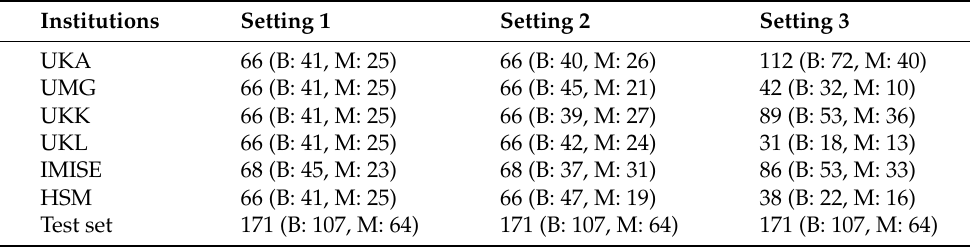
Table 1. Class distributions over the six Germany-wide institutions (UKA, UKK, UKL, UMG, HSM, IMISE), where setting 1: equal sized and balanced class distribution; setting 2: equal sized and unbalanced class distribution; and setting 3 unequal sized and unbalanced class distribution. The meaning of the abbreviations are: malignant (M) or benign (B). Institutions Setting 1 Setting 2 Setting 3